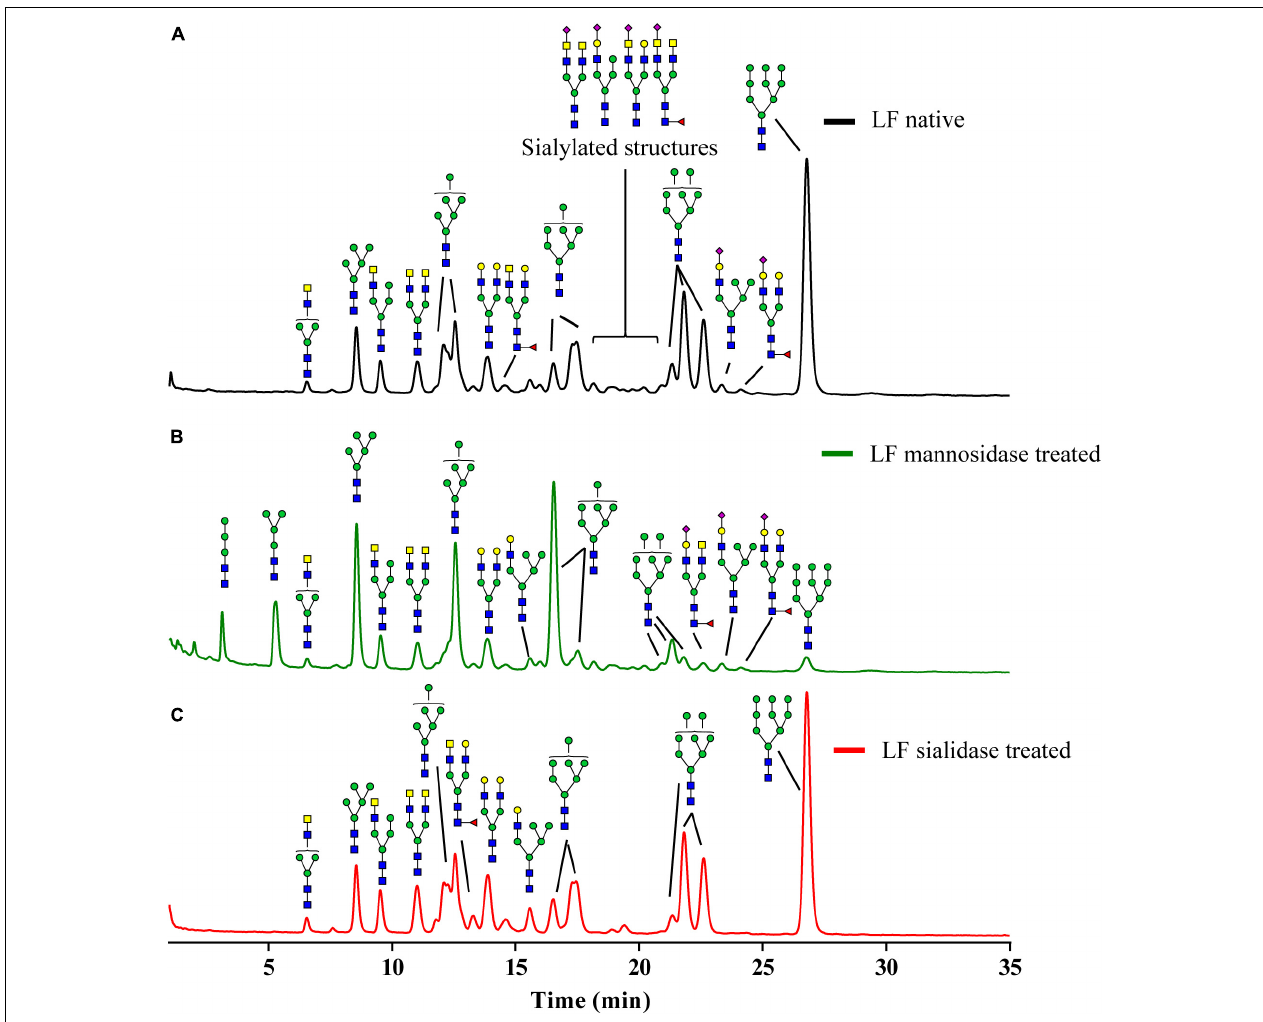
FIGURE 2 | Glycoprofile of the N -glycans isolated from bLF. (A) Native isolated N -glycans, (B) partially demannosylated N -glycans, and (C) partially desialylated N